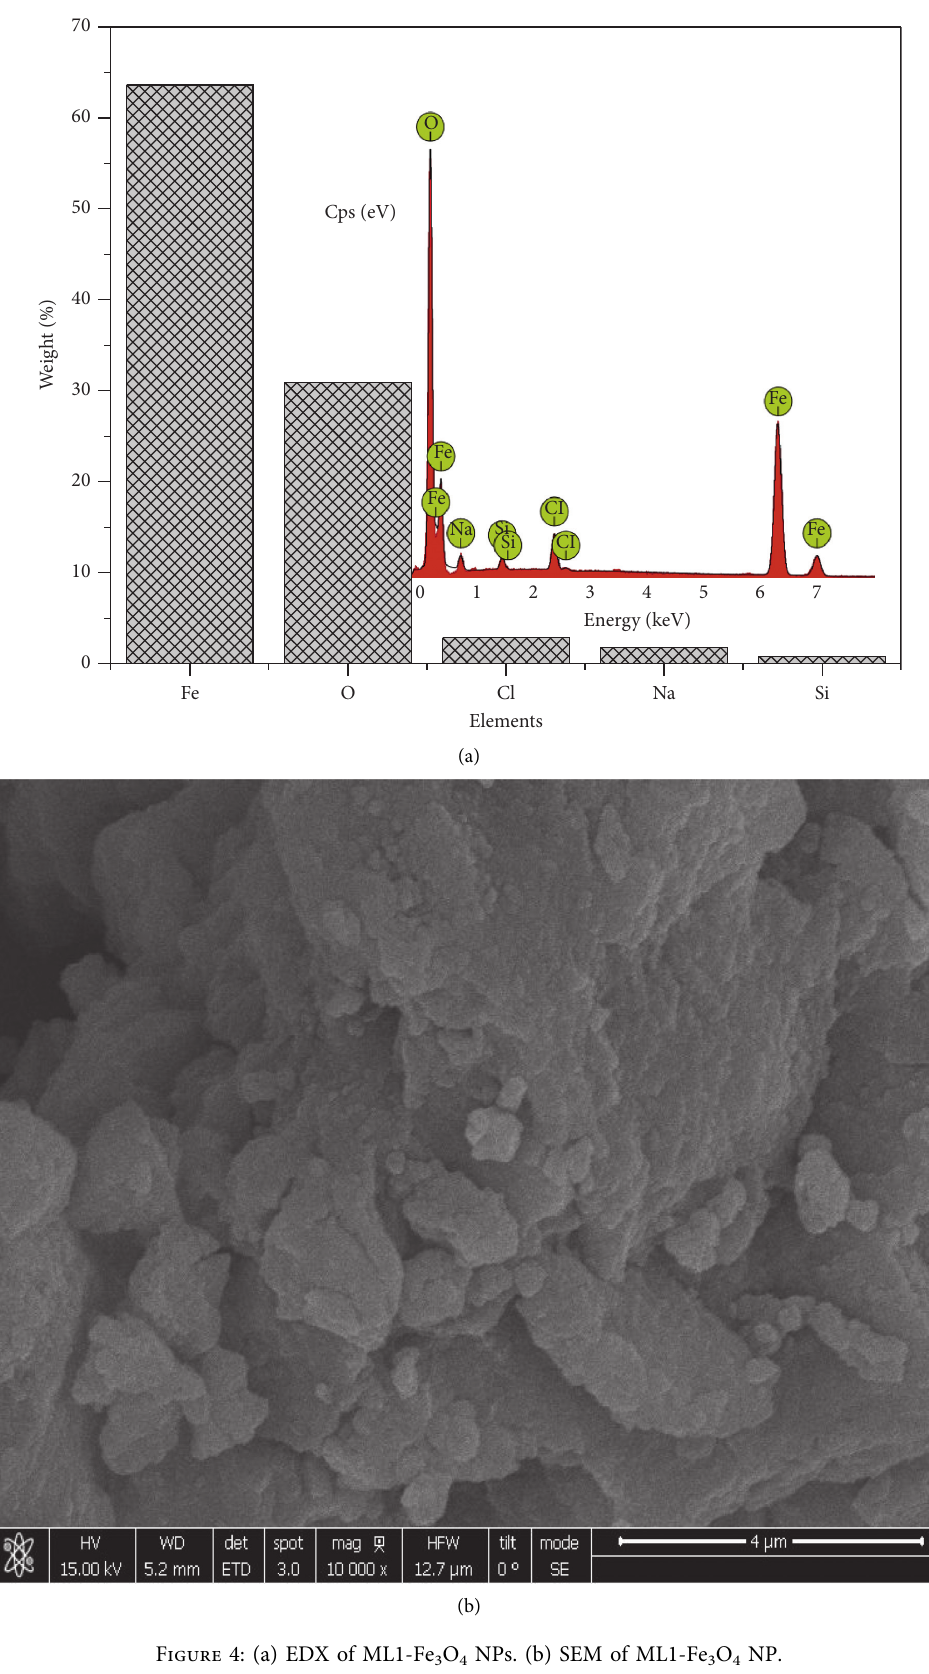
Figure 4: (a) EDX of ML1-Fe 3 O 4 NPs. (b) SEM of ML1-Fe 3 O 4